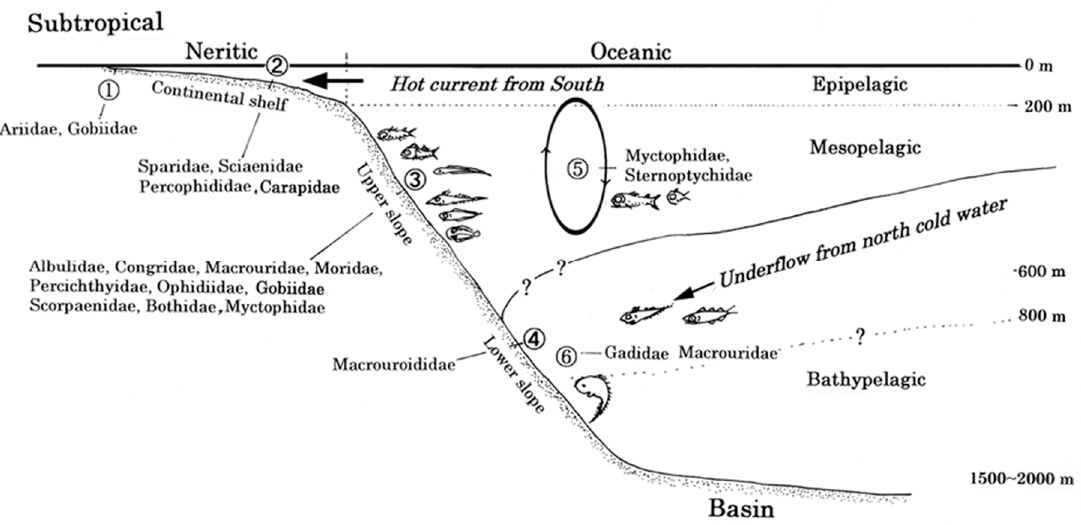
Figure 7. Environmental reconstruction of Nobori fish fauna.